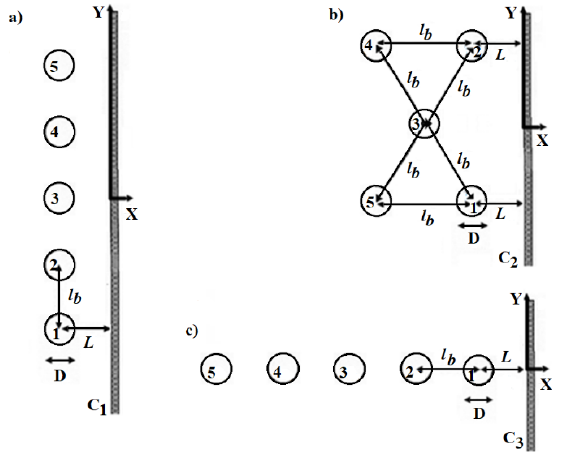
Figure 2. Three different examined WEC array configurations with respect to the incoming wave direction: ( a ) the array is placed in parallel arrangement to the wall, C 1 ; ( b ) the array is placed in a rectangular arrangement in front of the wall, C 2 ; and ( c ) the array is arranged perpendicularly to the wall, C 3 .